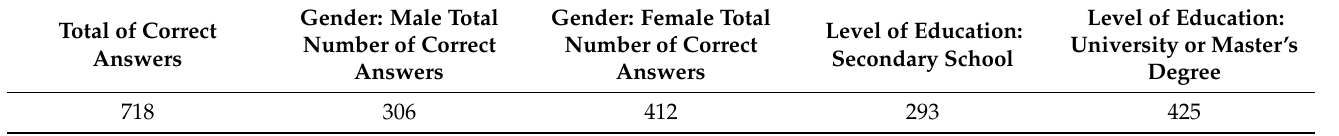
Table 10. Posttest 1 results regarding gender and level of